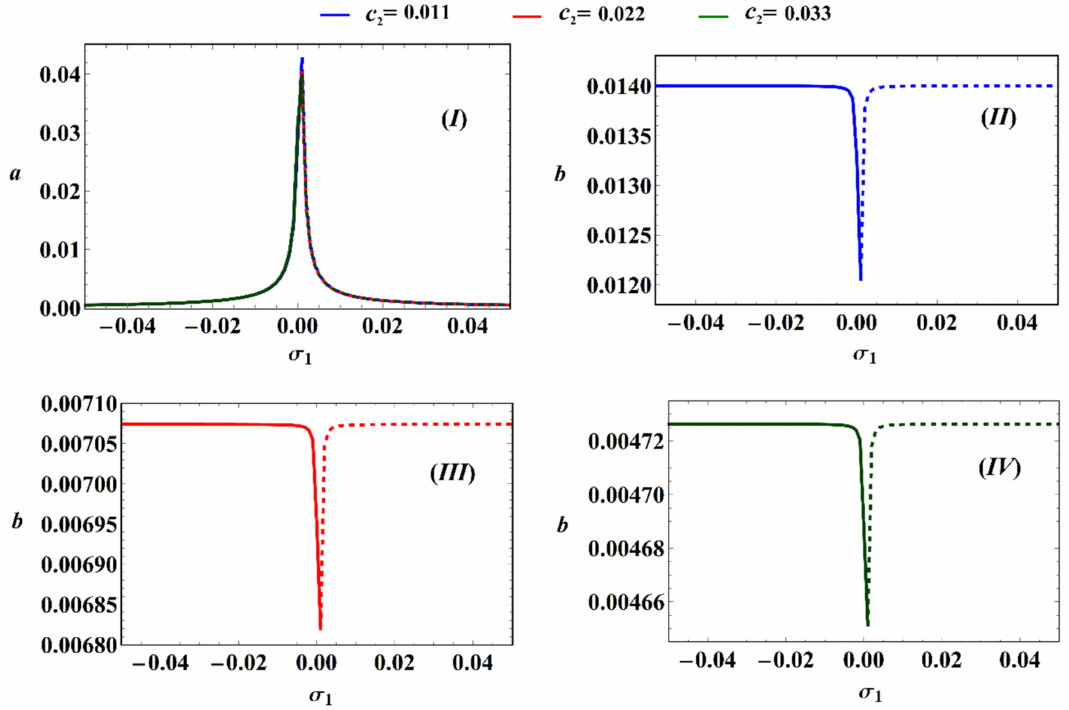
Figure 16. The frequency response at σ 2 = − 0.001, W = 0.448, and c 1 = 0.001 for: a ( σ 1 ) as shown in ( I ), and b ( σ 1 ) as it is in ( II – IV ) when ( c 2 = 0.011, c 2 = 0.022, c 2 = 0.033